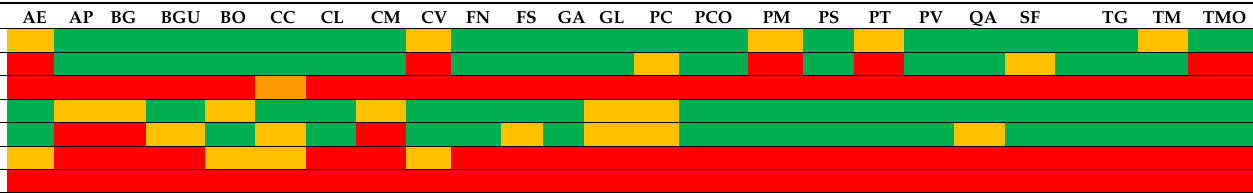
Table 4. Results obtained for the Biodiversity indicators of the different UFs.